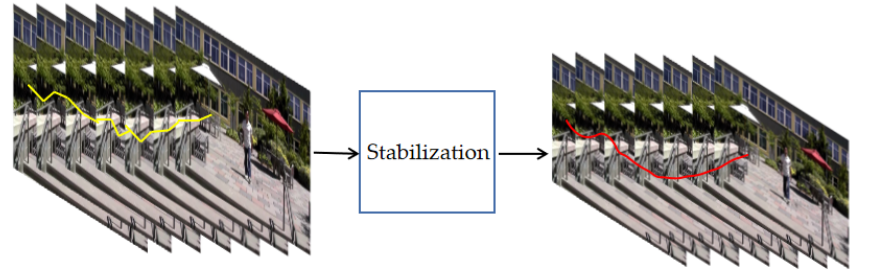
Figure 1. Motion accumulation of unstabilized video and stabilized